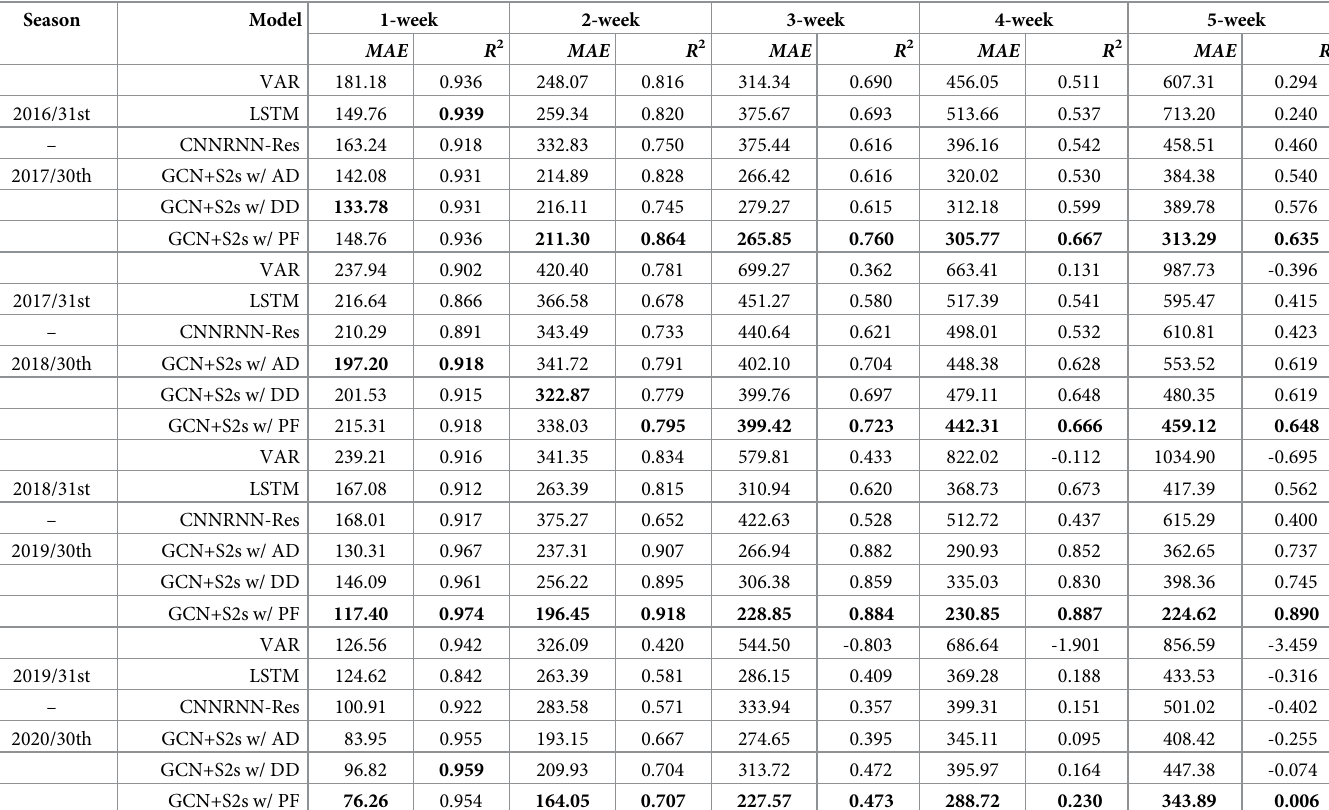
Table 2. Regional prediction model performances (averaged across all 47 prefectures in